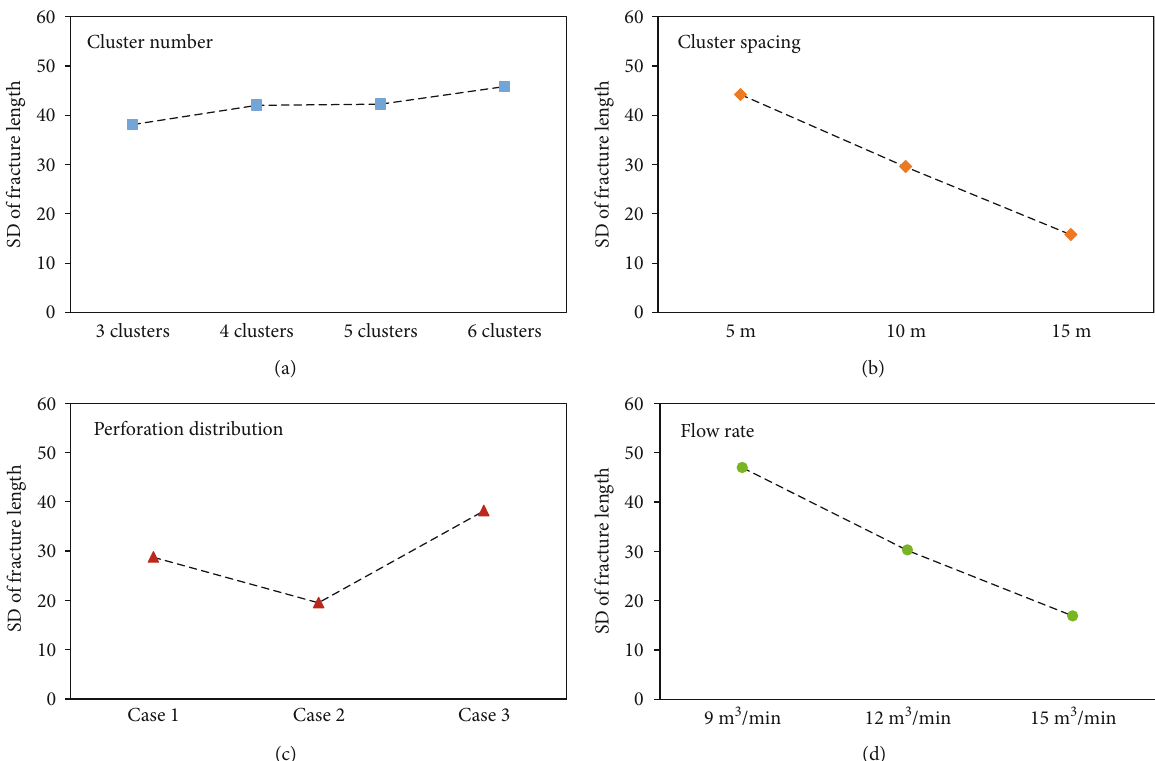
Figure 11: Standard deviation of fracture length: (a) cluster number, (b) cluster spacing, (c) perforation distribution, and (d) fl ow